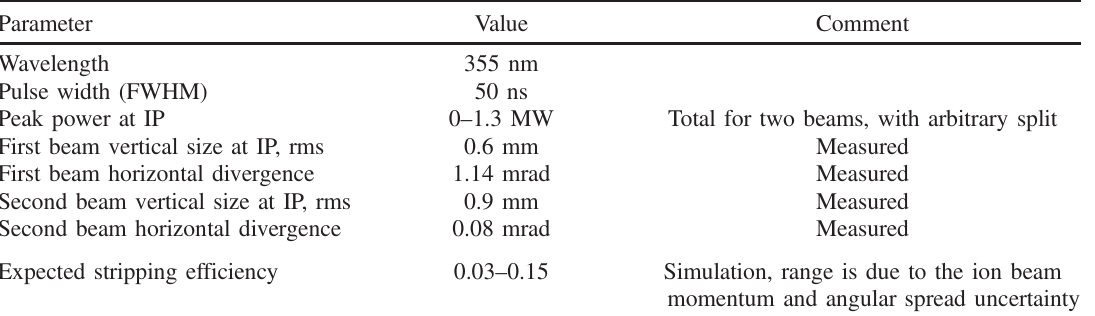
TABLE II. Laser beam parameters in the experiment.